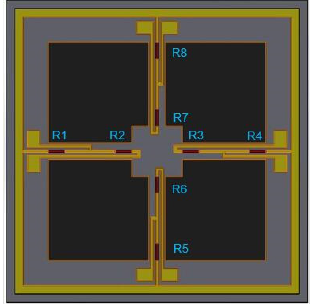
Figure 6. The distribution diagram of piezoresistors on beams.